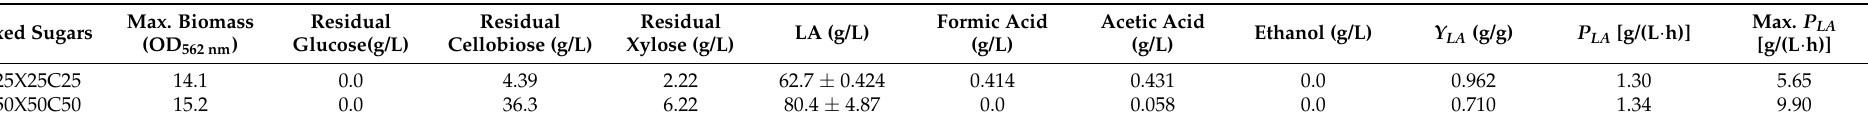
Table 6. Effect of different ratios of glucose/cellobiose/xylose mixtures on sugar utilization and lactic acid fermentation efficiency by B. coagulans Azu-10. Max. Biomass Residual Residual Mixed Sugars (OD 562nm ) Glucose(g/L) Cellobiose